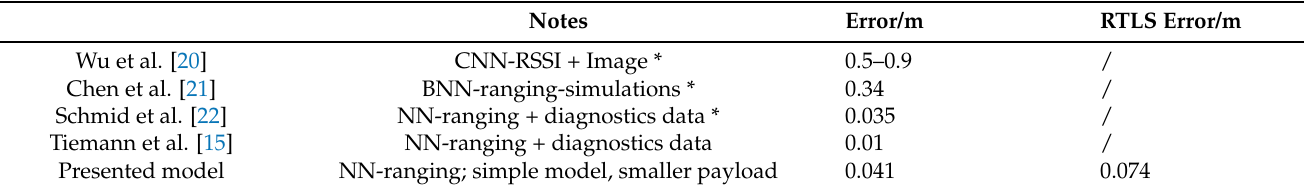
Table 7. Results from previous research with the use of NN in ranging. Error column represents ranging errors obtained with similar data as was used in NN training. The RTLS error column is presenting ranging errors obtained with NN models with RTLS measurements in realistic